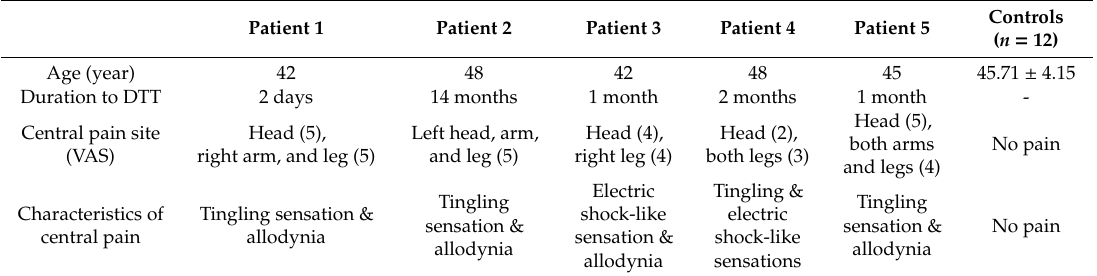
Table 1. Demographic and clinical data for the patients and control